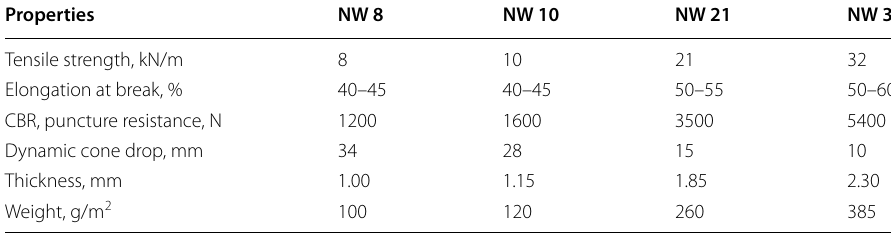
Table 2 Properties of thermally bonded nonwoven geotextiles (NW series) Properties